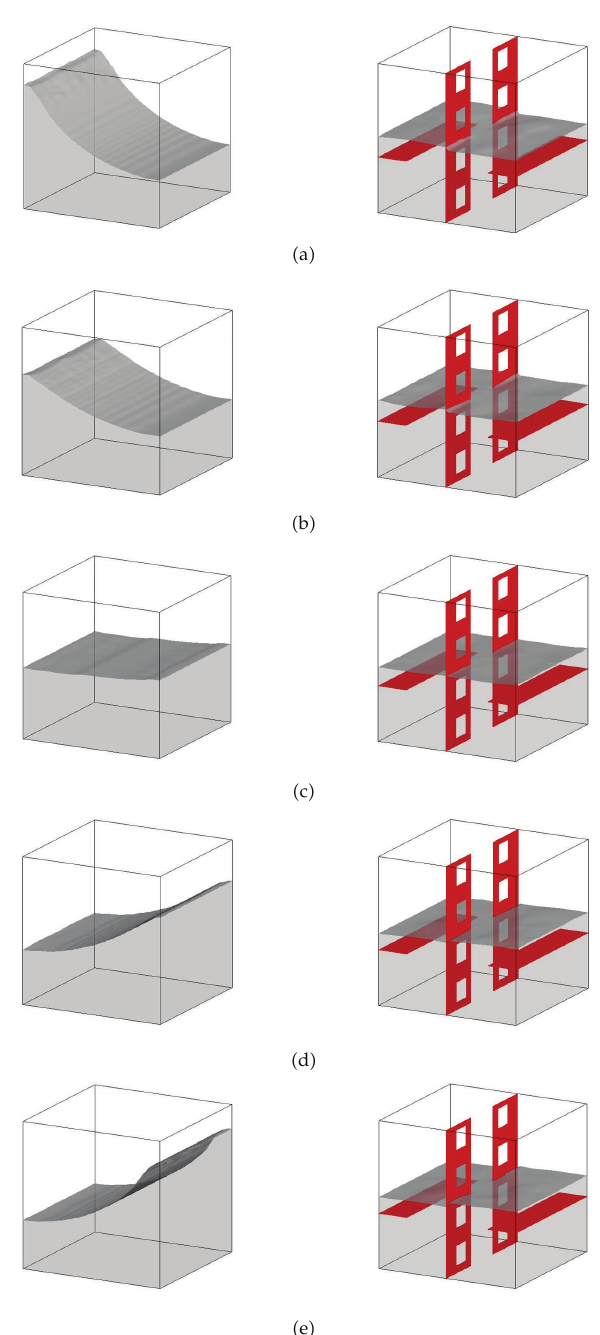
Figure 11: Snapshots of liquid sloshing in cubic tank without and with multiple ba ffl es at t (cid:9) 8 . 90, 9.05, 9.15, 9.25, and